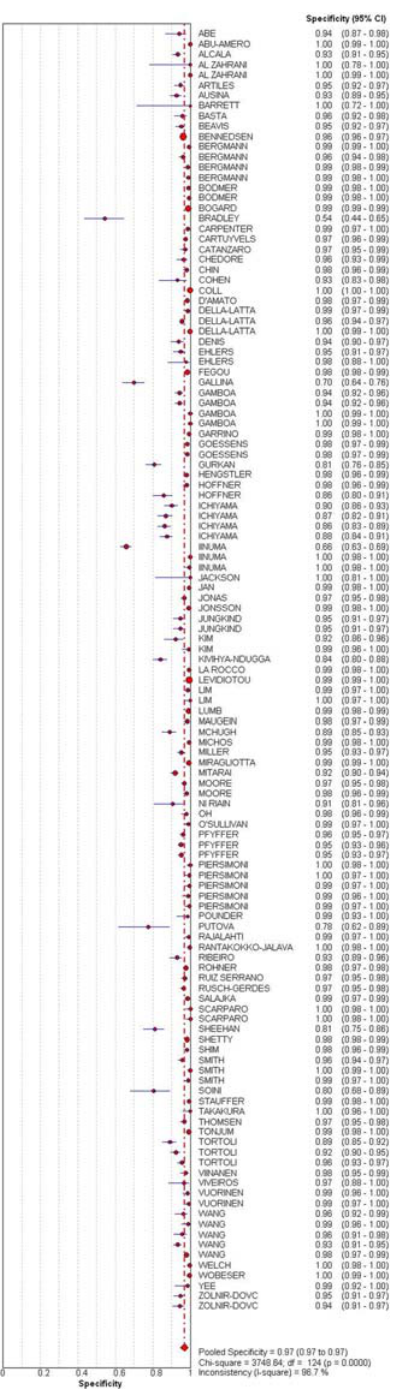
Figure 2. Forest plot of sensitivity estimates and 95% CI. Point estimates of sensitivity from each study are shown as solid circles. The solid lines represent the 95% confidence intervals (CI). Circles are proportional to study size. The pooled estimate is denoted by the diamond at the bottom.